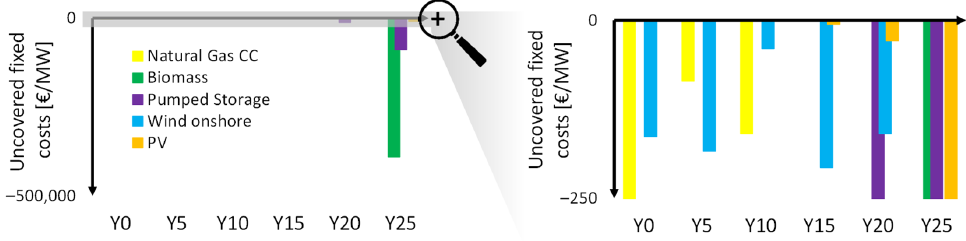
Figure 7. Uncovered fixed costs for invested technologies in iteration 0.